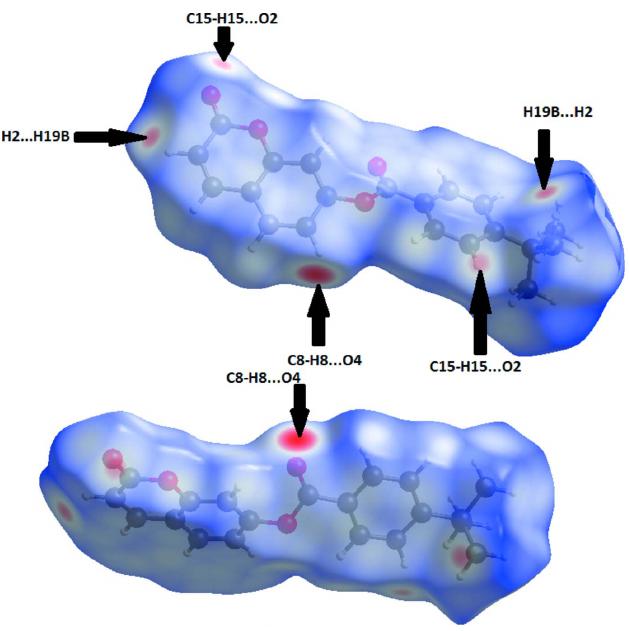
Figure 5 A View of the Hirshfeld surfaces with the three-dimensional d norm